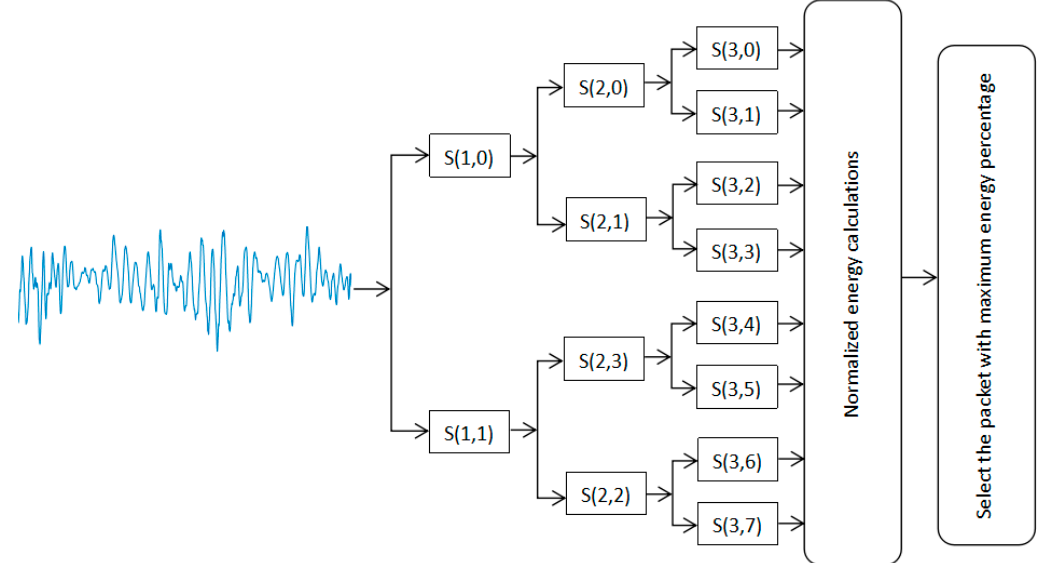
Figure 19. Block diagram of the Wavelet Packet Energy method used to extract the knock characteristics of the engine block vibration signal under a weak knock condition at 5200 rpm.